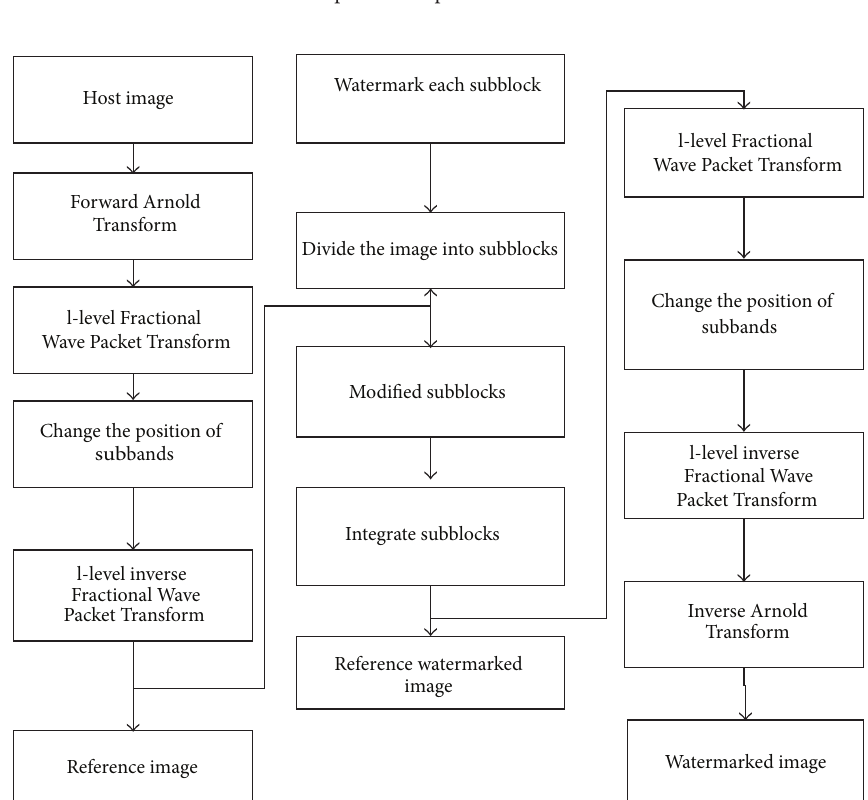
Figure 2: Watermark